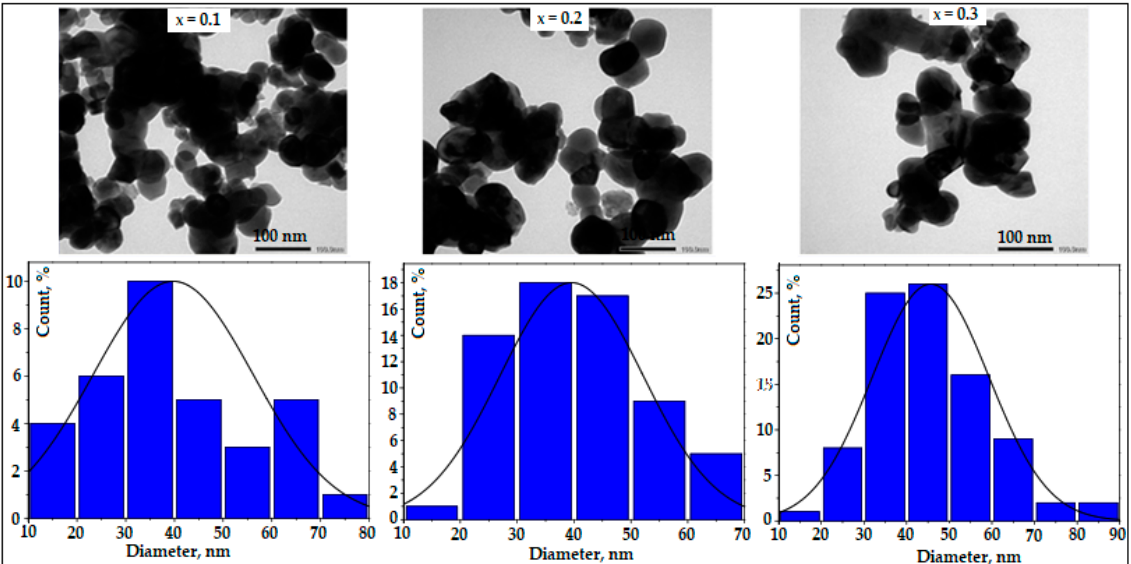
Figure 3. Transmission electron microscopy (TEM) images and particle size distribution of NdFe 1 − x Co x O 3 samples annealed at 750 ◦ C.